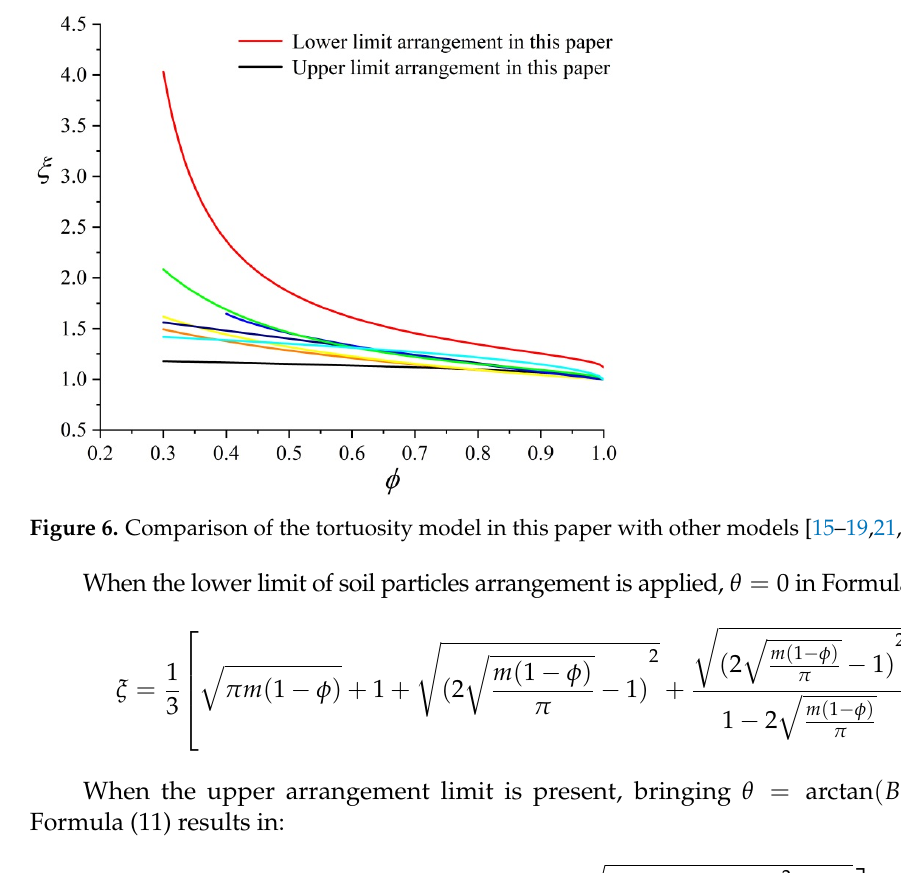
Figure 5. Comparison of the proposed model of tortuosity with previously published [22] results— lower limit arrangement.